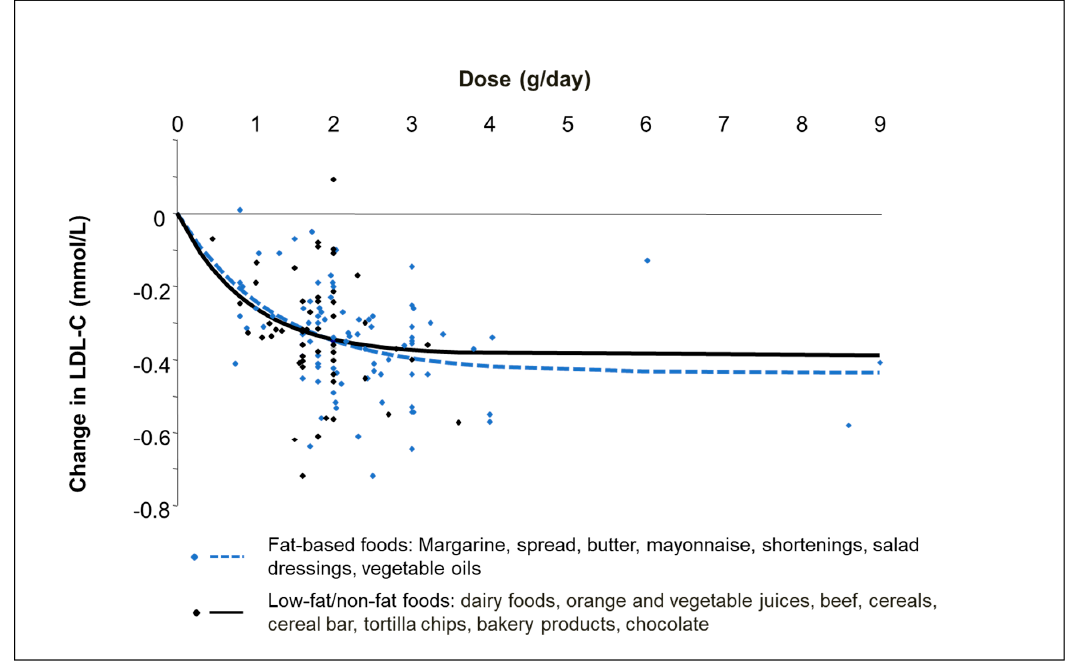
Figure 1. Dose-response curves of the absolute LDL-cholesterol (LDL-C) lowering effect of (combined) plant sterols and stanols added to fat-based foods as compared to low-fat/non-fat foods (based on meta-analysis of Demonty et al. 2009 [5]).